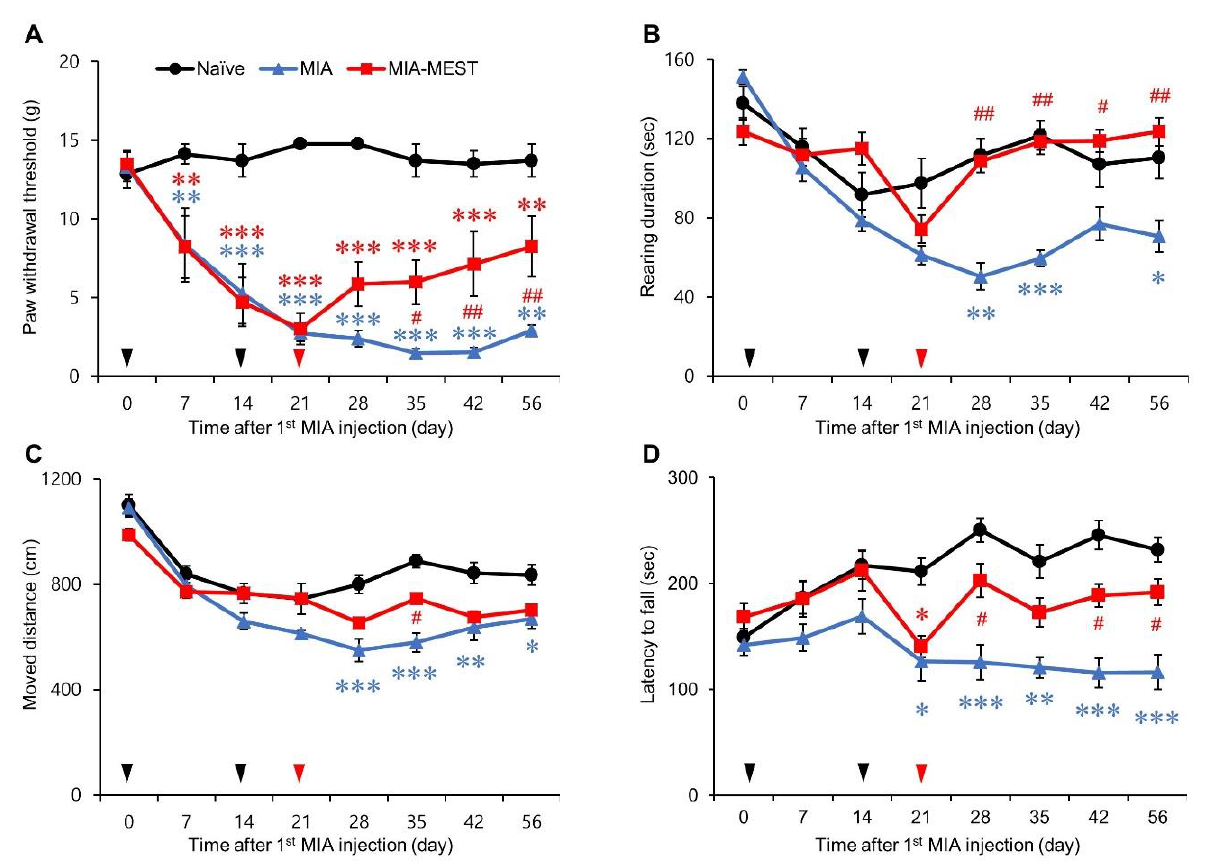
Figure 2. MEST alleviates MIA-induced pain and motor deficit. Paw withdrawal threshold to von Frey filaments ( A ). Time spent for rearing ( B ). Covered distance in an open cage ( C ). Fall latency from rotarod ( D ). Black and red arrowheads indicate MIA injections and MEST, respectively. * p < 0.05, ** p < 0.01, *** p < 0.001 vs. Naïve control. # p < 0.05, ## p < 0.01 vs. MIA group. N = 7–8 per group. Data are presented as mean ± SEM.